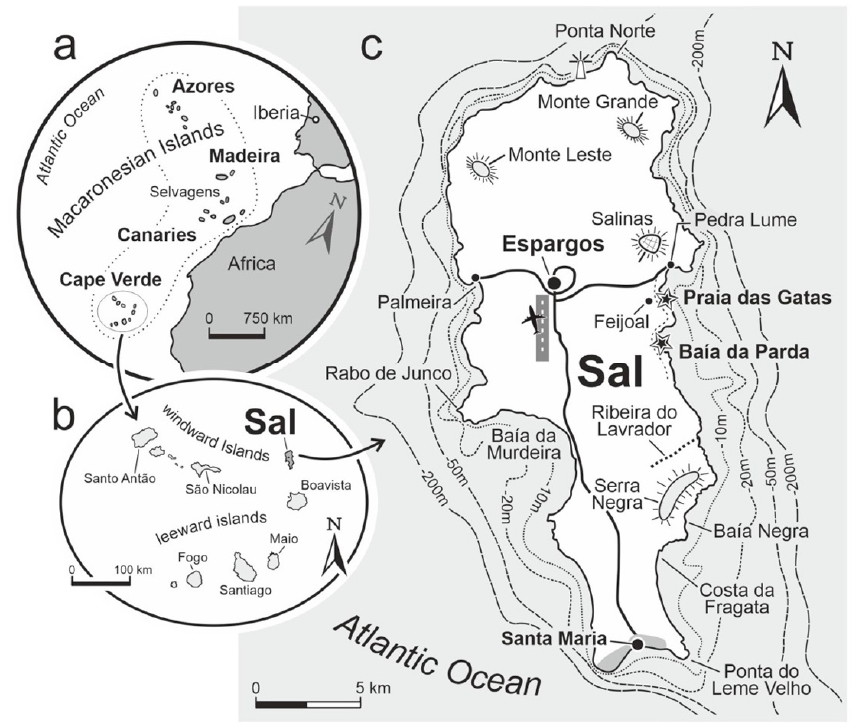
Figure 1. Maps showing the location of Sal Island in the Northwest Atlantic Ocean ( a ) with respect to other islands in the Cabo Verde archipelago demarking the 4000 m line of bathymetry ( b ), as well as the island’s detailed shelf bathymetry ( c ). Modified from Johnson et al. (2017) [6].